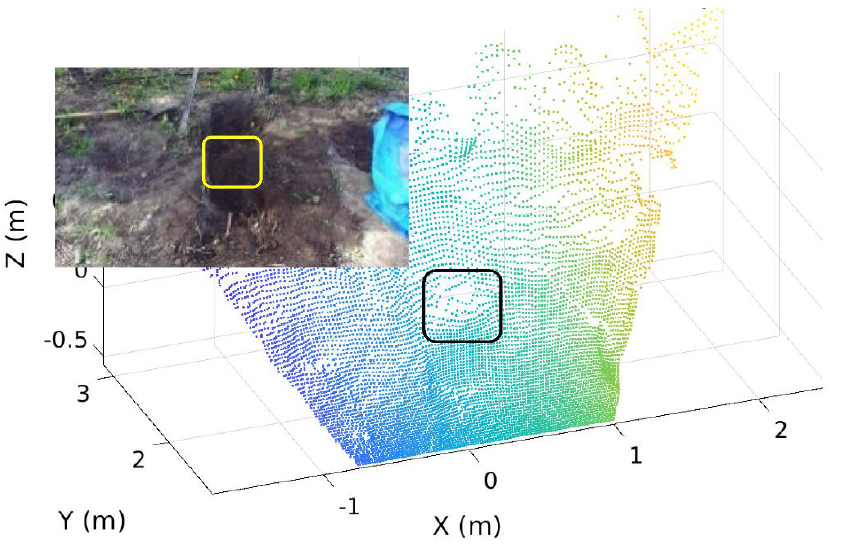
Figure 23. Occluded areas at the front side with the Field of View (FOV) blockage before excava- tion.